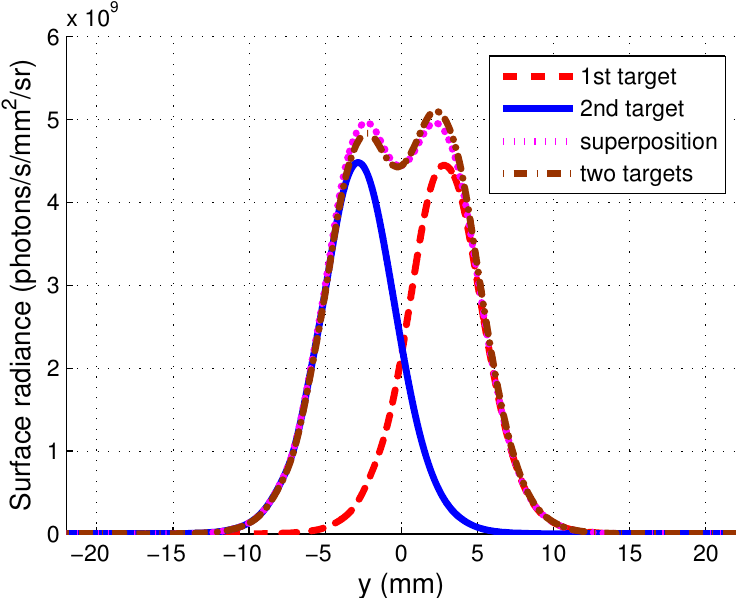
Figure A3. Spatial distribution of fluorescence emission light from fluorescent